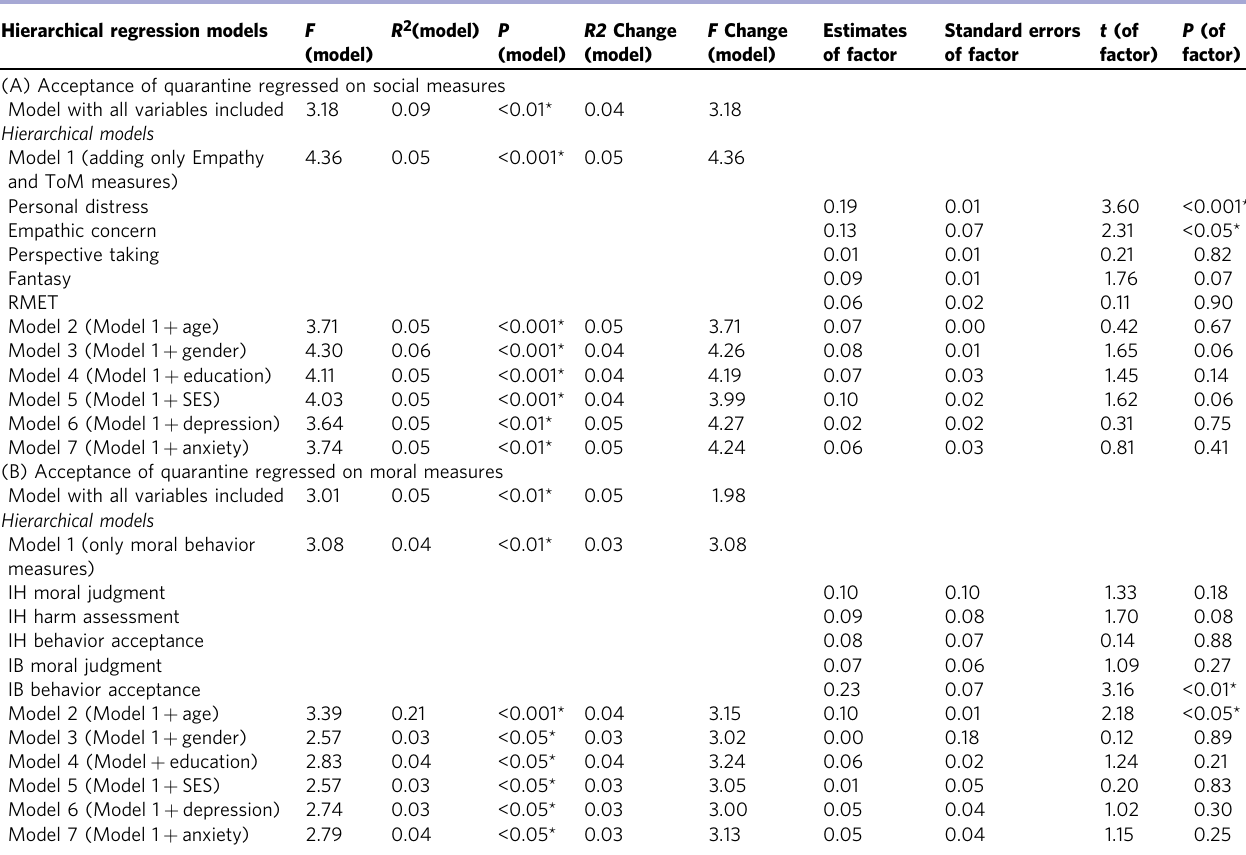
Table 4 Regression models on impact estimation. Hierarchical regression models